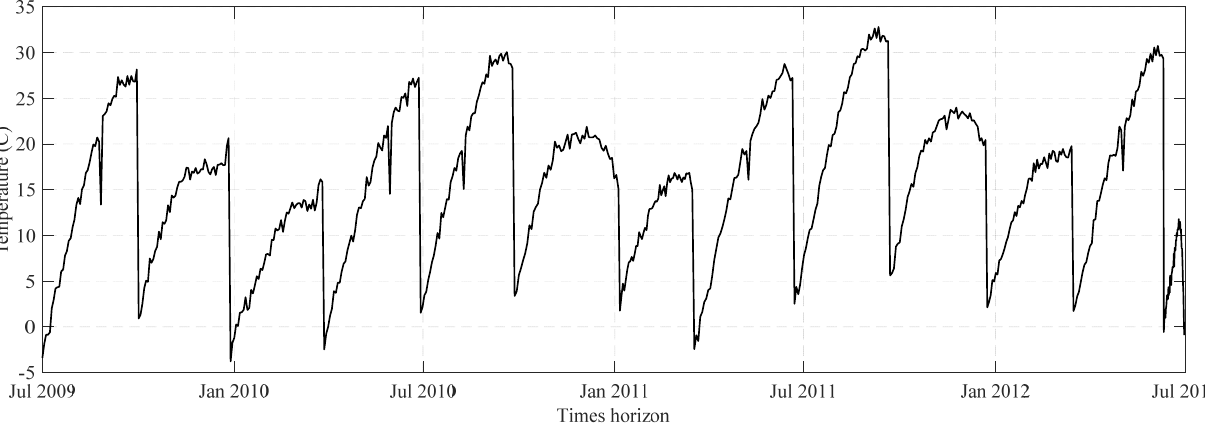
Figure 1. The seasonal thermal trend of Kepler spacecraft’s RW.